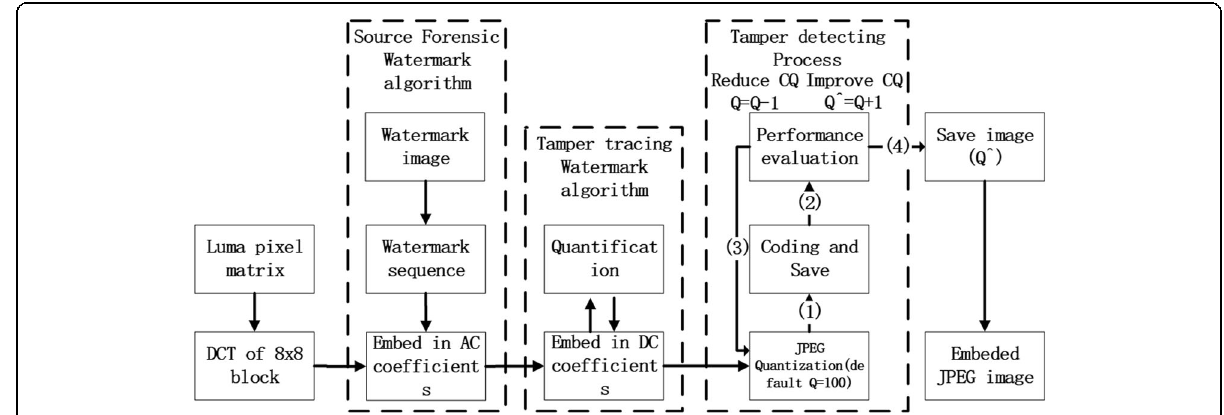
Fig. 6 Flow of watermark embed